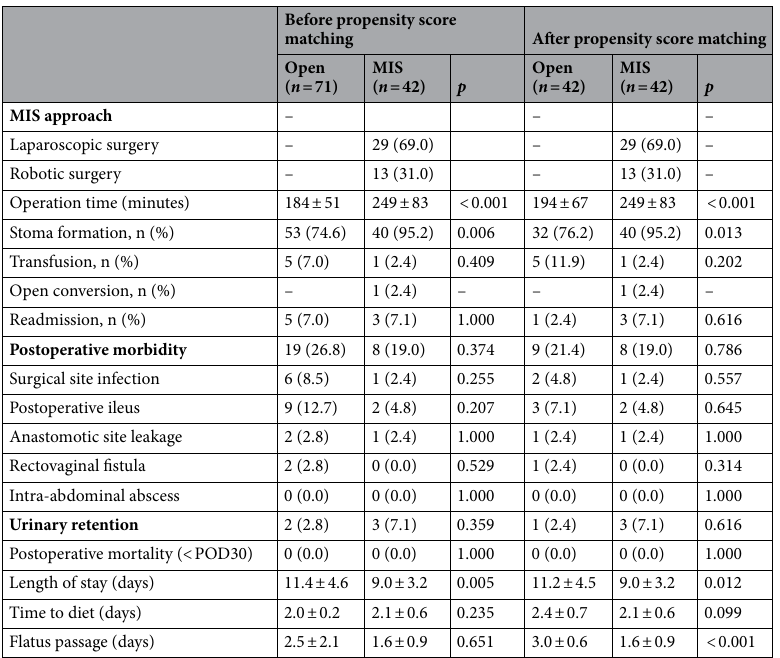
Table 6. Perioperative and short-term outcomes of patients with nCRT. nCRT neoadjuvant chemoradiotherapy, MIS minimally invasive